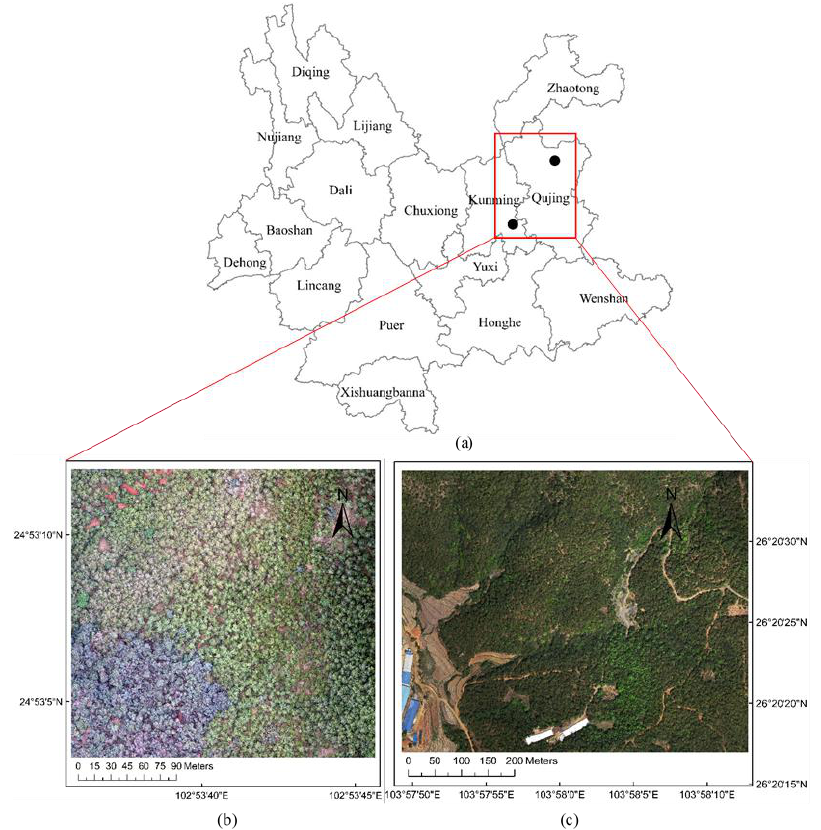
Figure 1. Location ( a ) and orthophotos of study area I: Songmao Reservoir ( b ) and study area II: Longtan town ( c ).